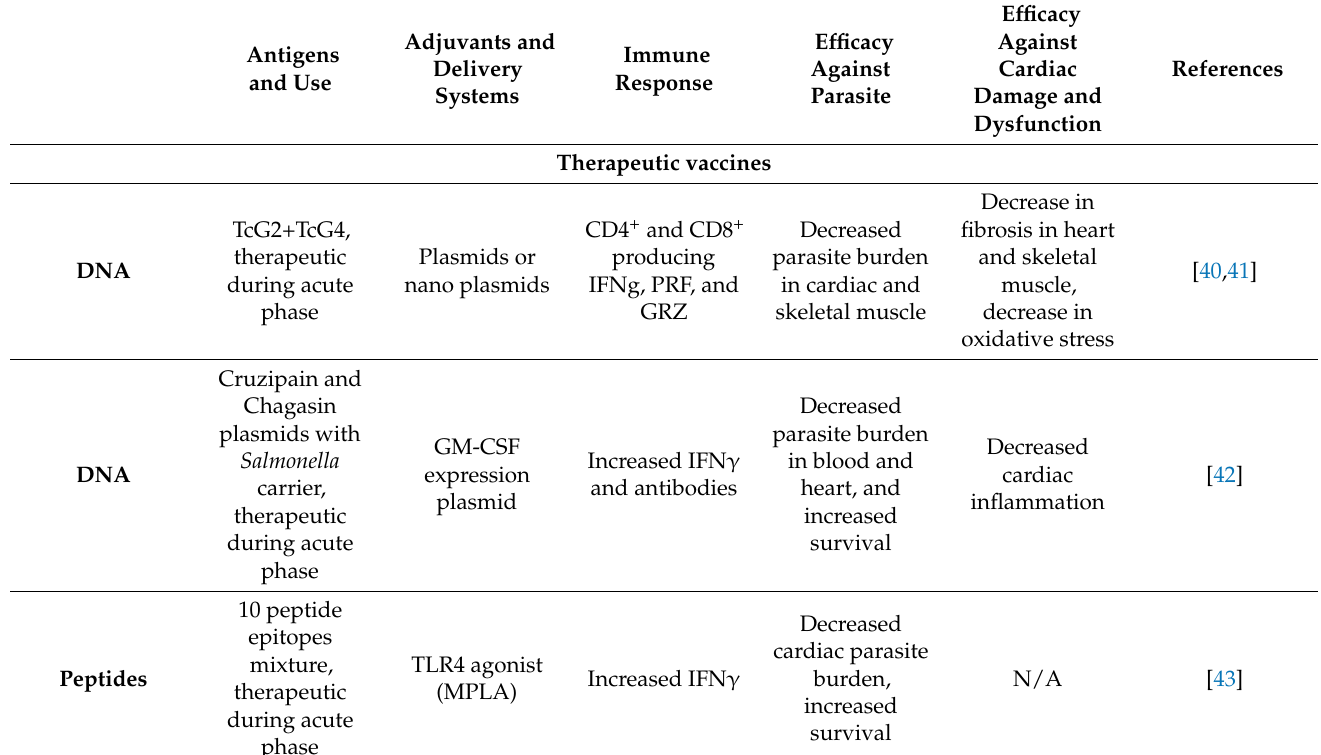
Table 1. Recent Chagas Disease Vaccine Platforms and